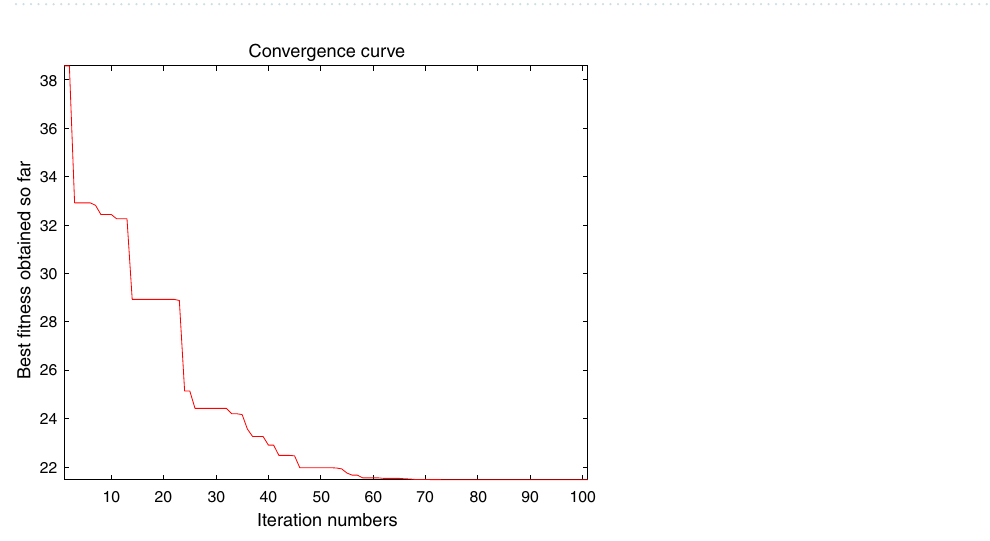
Table 20. Comparative results of LFGOA with other methods for car side impact design. The best of the comparison results are in [bold].